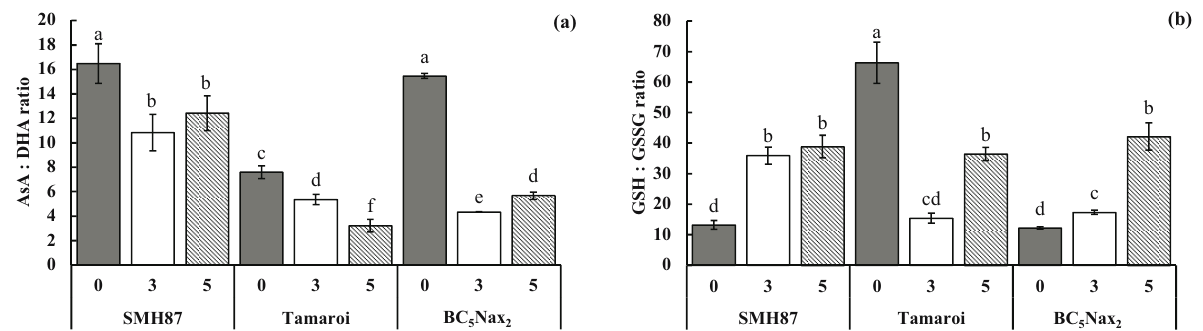
Figure 5: Ascorbate ( AsA )- to - dehydroascorbate ( DHA ) ratio ( a ) and reduced - to - oxidized glutathione ratio ( GSH:GSSG ) ( b ) in the fl ag leaves of three durum wheat genotypes grown in the soil contaminated with Cd at 0 mg ( control ) , 3 mg kg − 1 DM and 5 mg kg − 1 DM. Data are represented as mean ± SE in fi ve replicates. Means with di ff erent letters ( a, b, c, … ) are signi fi cantly di ff erent at P < 0.05 using the Duncan multiple range